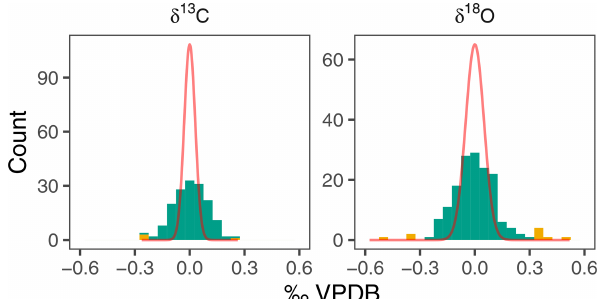
Figure 3. Within-sample variability in N. pachyderma stable iso- topes exceeds analytical noise. Histograms of residual δ 18 O and δ 13 C compared to expected density distribution if variability were due to analytical uncertainty alone (red line). Yellow colours indi- cate outliers (see